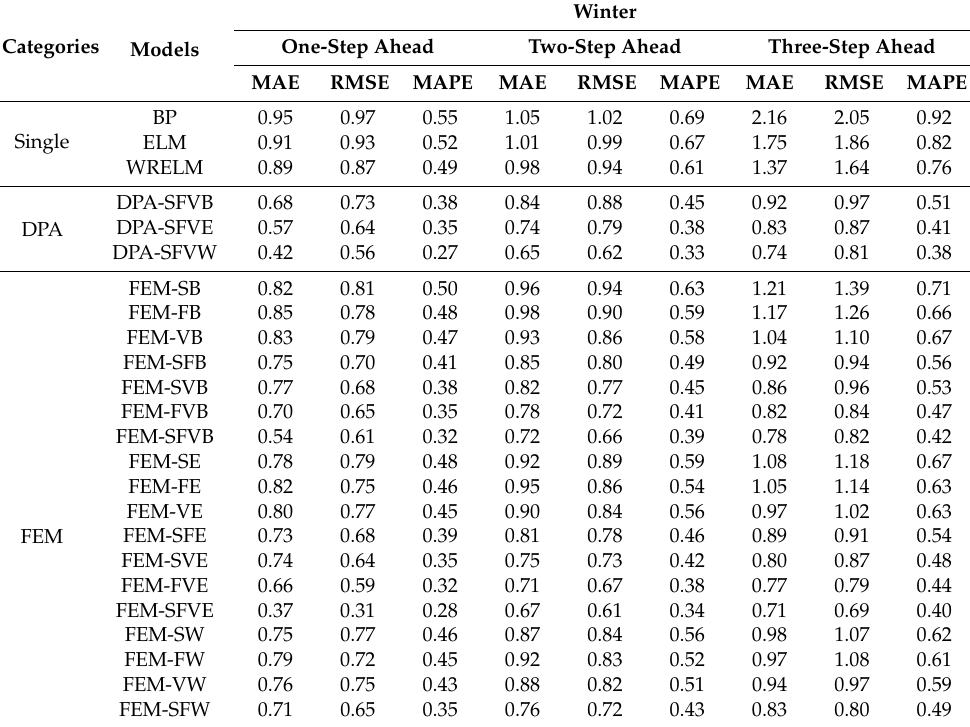
Table 9. Comparison of prediction performances of different models in